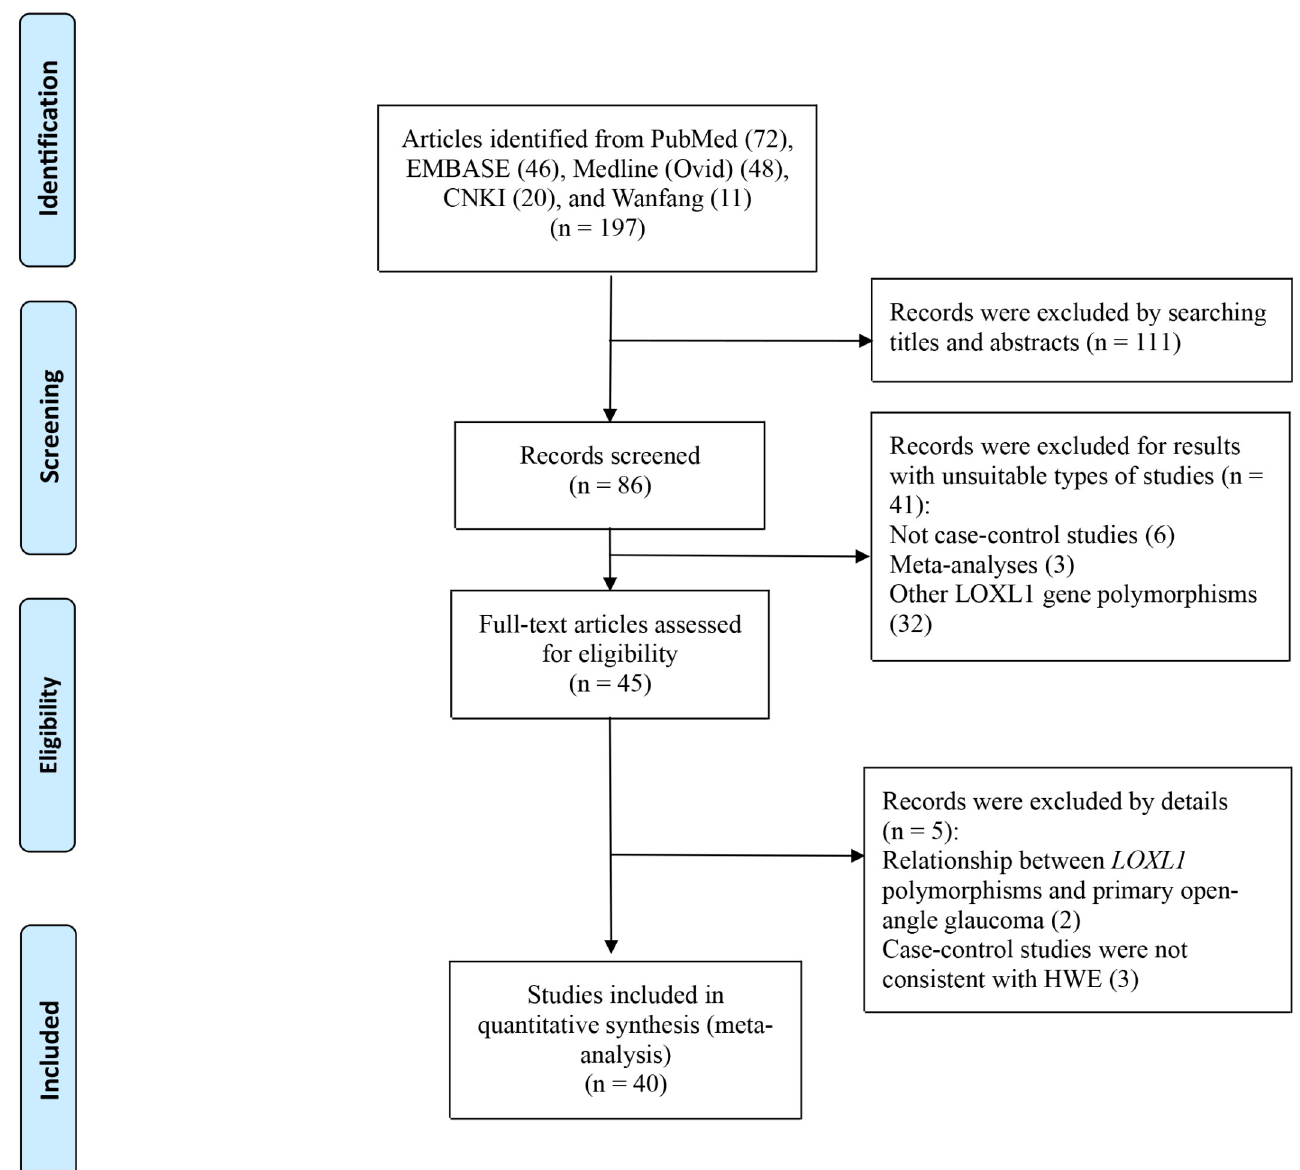
Fig 1. Flow diagram of studies